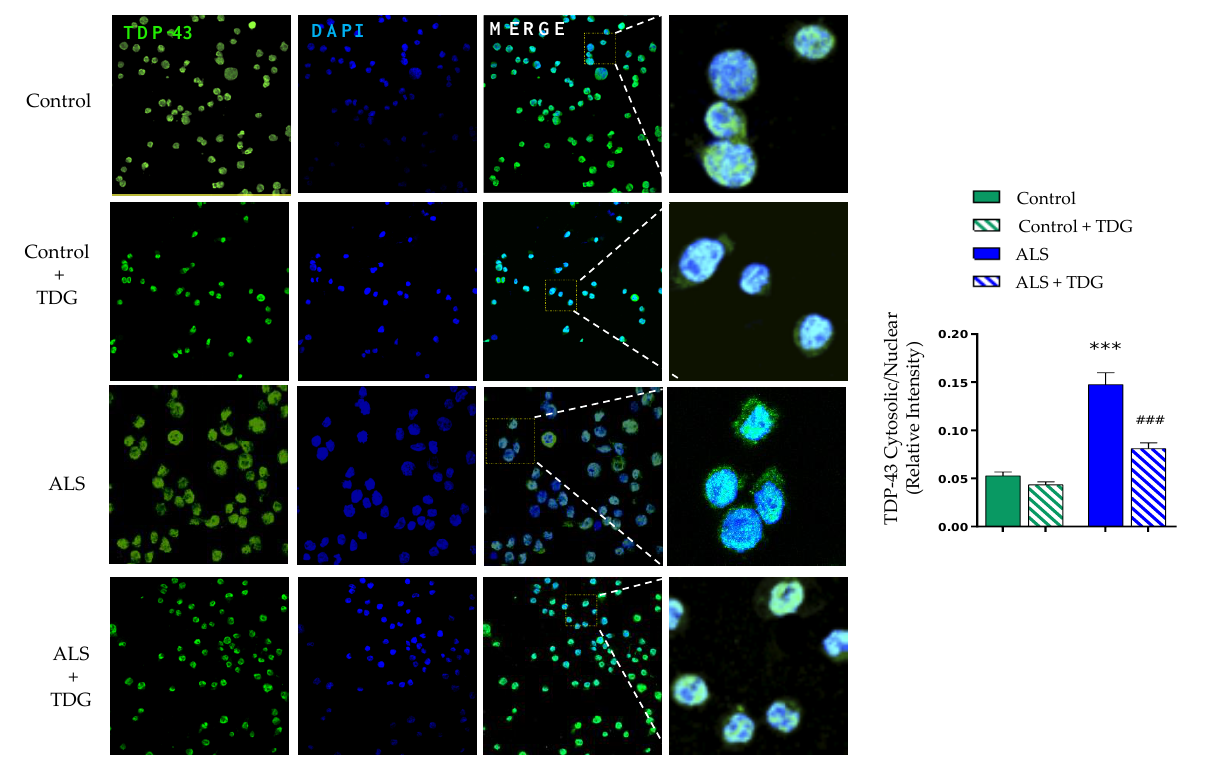
Figure 3. Confocal microscopy analysis of the subcellular localization of TDP-43 after Tideglusib treatment on ALS patients and control lymphoblast. Lymphoblasts (1 x 10 6 cells × mL −1 ) were incubated with and without Tideglusib (TDG: 5 μM) for 24 h. Confocal laser scanning microscopy was used to examine TDP-43 protein localization. DAPI was used to stain cell nucleus. Relative fluorescence intensity of TDP-43 inside and outside nuclei was determined in two cell lines from each group in at least 45 cells per individual. The plotted values represent the mean ± SEM of quantitative analyses of TDP-43 redistribution (*** p < 0.001 significantly different from control cells; ### p < 0.001 significantly different from ALS untreated cells).